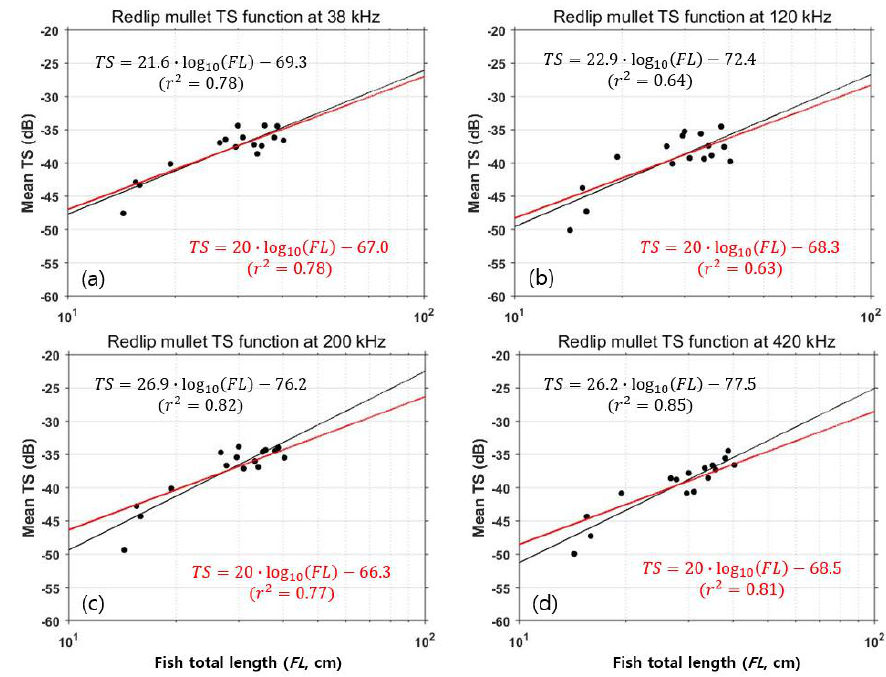
Figure 5. Relationships between target strength ( TS ) and total fish length ( FL ) at ( a ) 38, ( b ) 120, ( c ) 200, and ( d ) 420 kHz. Black points represent the mean TS values with FL . Black solid lines represent the least-squares regressions of mean TS , and the red solid line represents the standard fits of the TS functions.